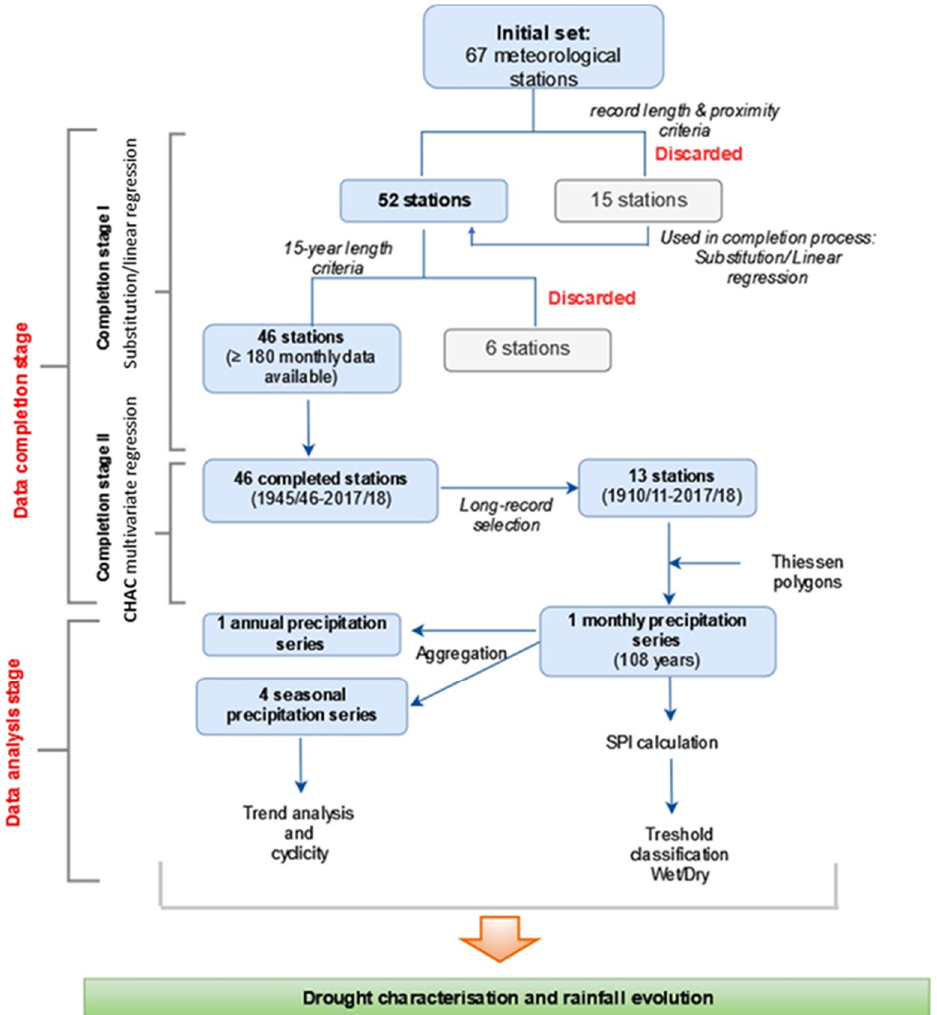
Figure 2. Workflow followed in this